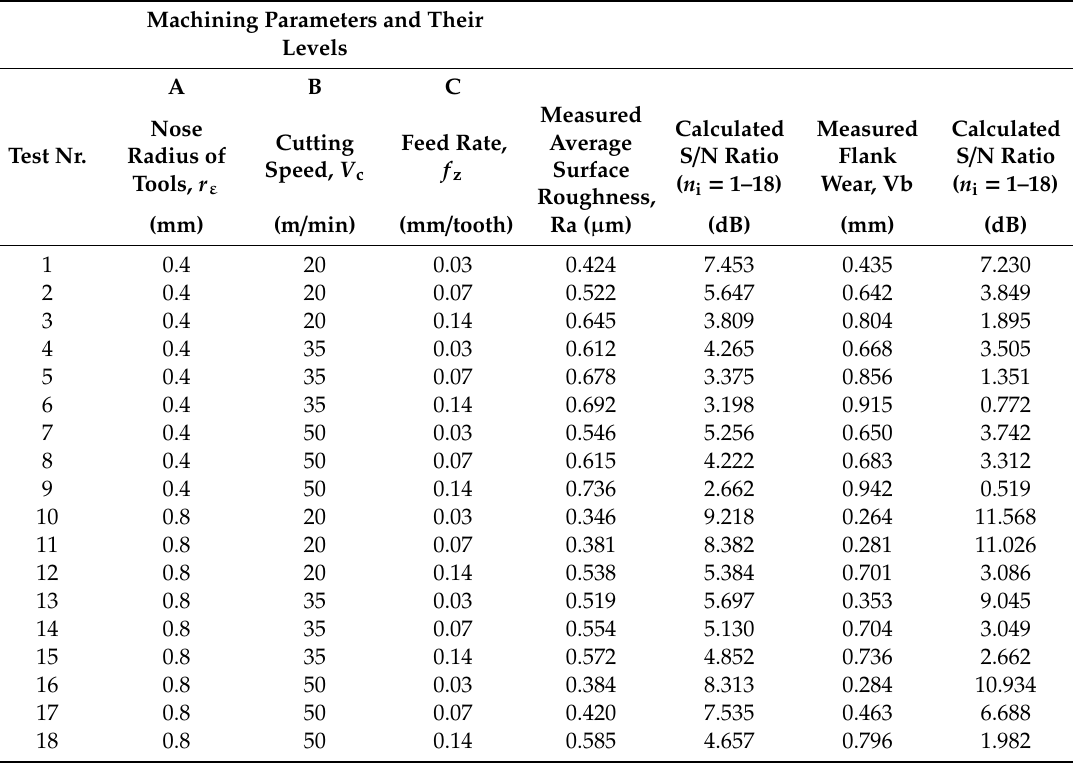
Table 6. The signal-to-noise (S / N) ratios for Ra and Vb.